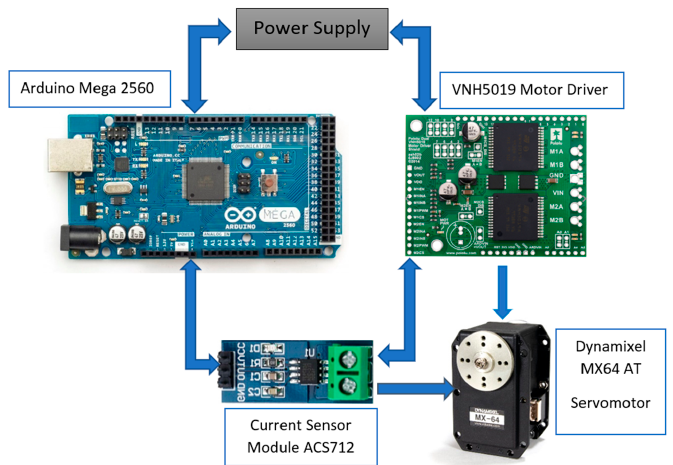
Figure 6. Drive wheel module assembly (physical model). ( a ) Internal view. ( b ) External view.